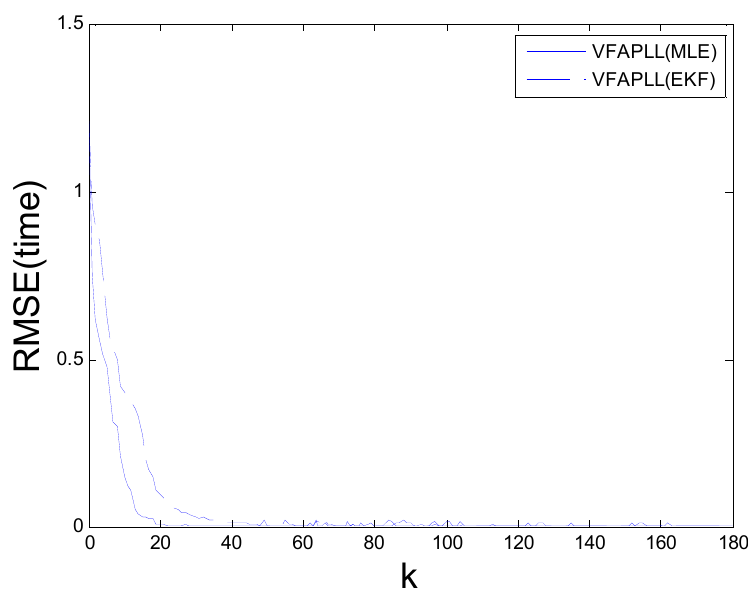
Figure 10. The relationship between RMSE time and moment k when CNR = 23 dB/Hz.